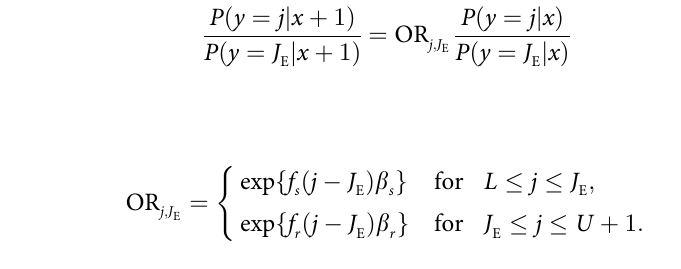
), f � 0 refers to no effect of x on the susceptible E s